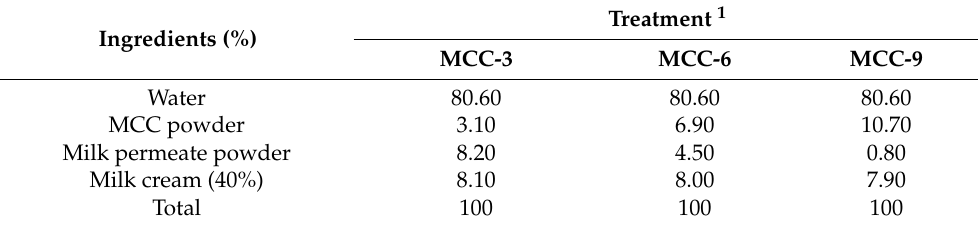
Table 1. Mean (n = 3) values of micellar casein concentrate (MCC) formulations made for making Feta-type